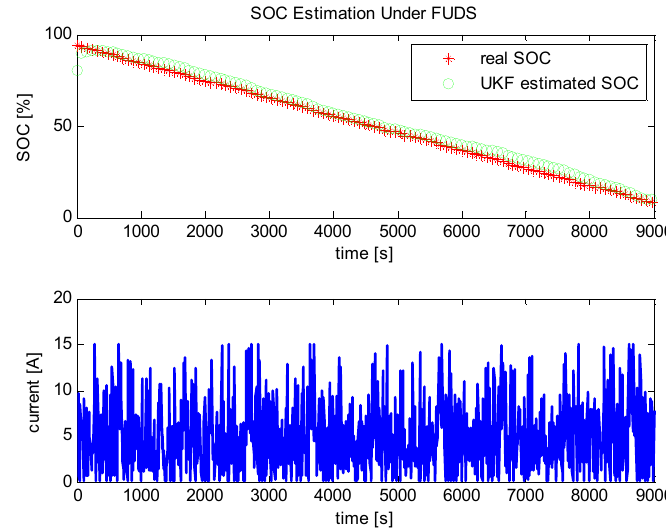
Figure 11. SOC estimation results for the type #2 battery under the FUDS